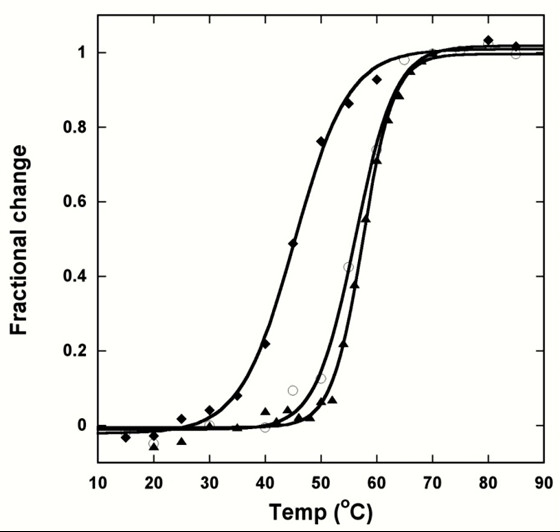
Thermal denaturation. The thermal denaturation of EEDDE in the presence of 1 mM EGTA (solid diamond), 10 mM Ca2+ (open circle), or 0.05 mM Tb3+ (solid triangle) in 10 mM Tris, 10 mM KCl. The solid lines are generated by fitting the data to Equation 1.